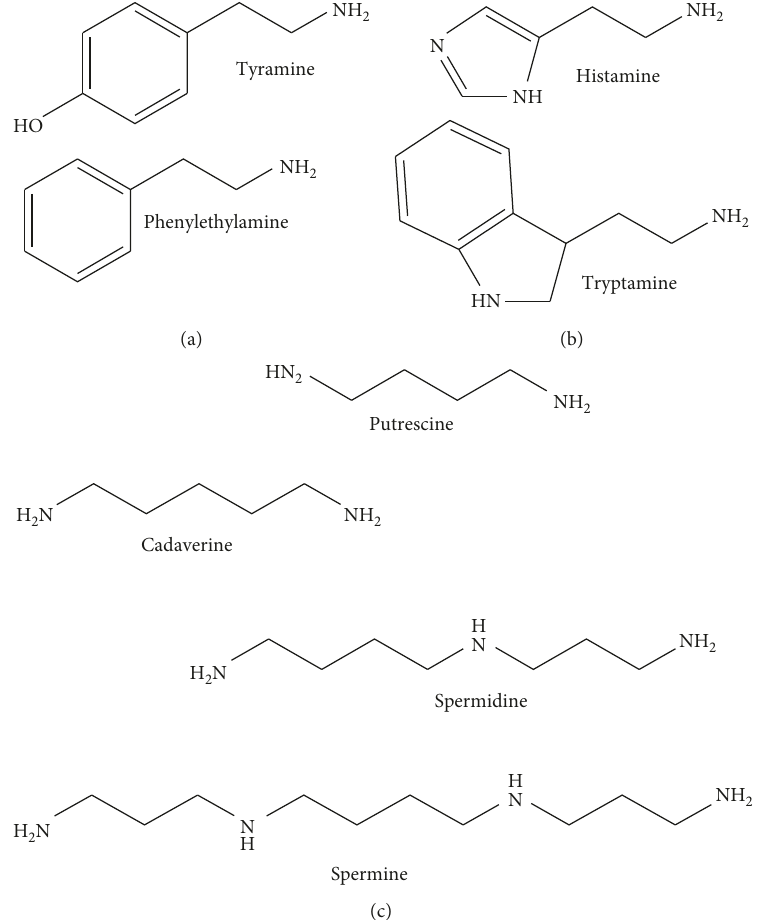
Figure 1: The main biogenic amines’ chemical structures found in food and beverages ([4] with modifications): (a) aromatic structure; (b) heterocyclic structure; (c) aliphatic